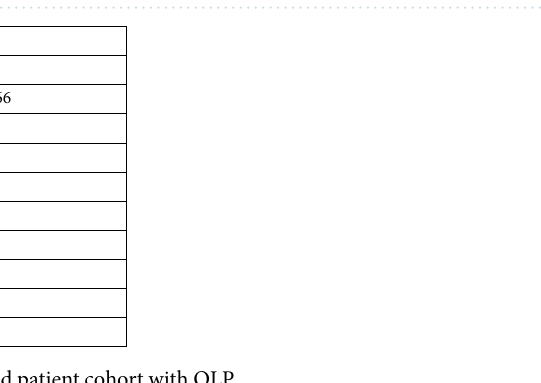
Figure 2. PDT leads to clinical amelioration of OLP. ( a ) PDT induces a reduction of lesion size over time (D1- D56). ( b ) PDT leads to reduction of ABSIS score I over time (D1-D56). ( c ) Photographically documentation of lesion size reduction over time (D1-D56). ( d ) PDT leads to a reduction of ABSIS II score over time (D1-D56). ( e ) QoL parameters (burning, pain, food, oral hygiene) are improved after PDT treatment (D1-D56). * p < 0.05, ** p < 0.01, *** p < 0.001. PDT, photodynamic treatment; QOL, quality of life.